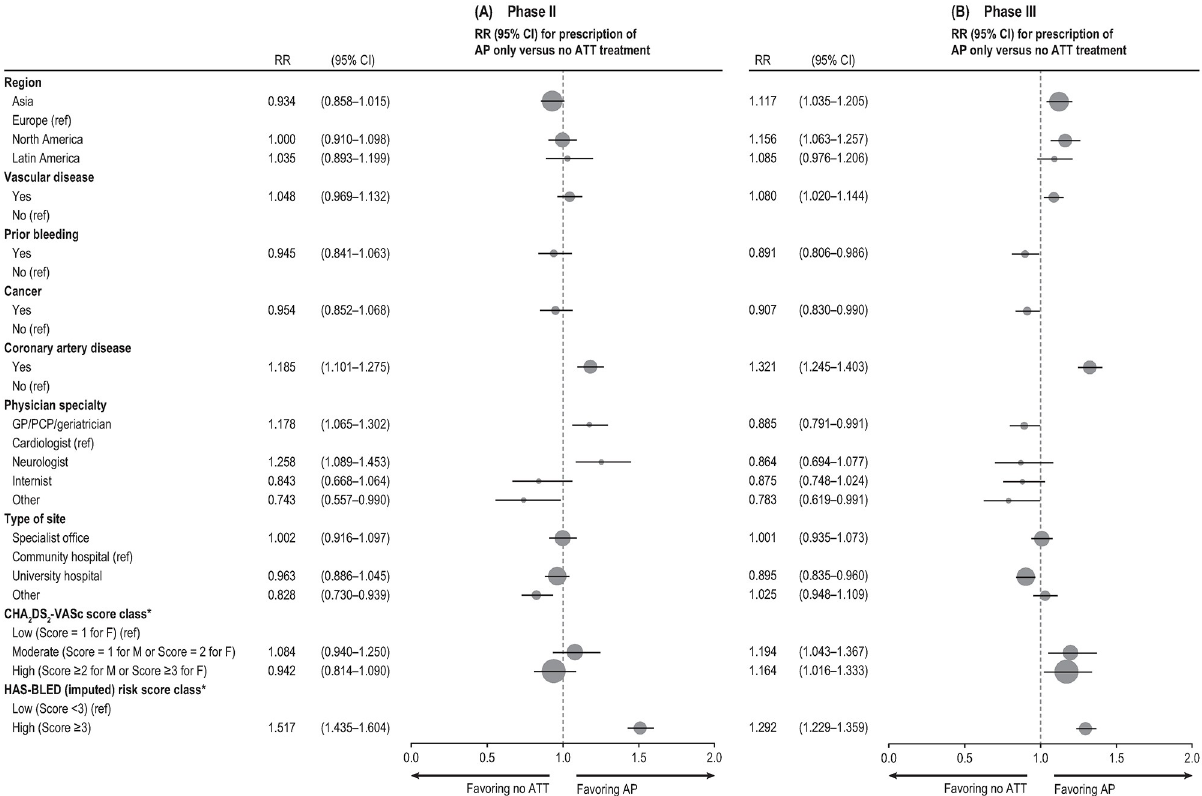
Fig 3. Factors most strongly associated with prescription of AP only versus no ATT in phase II (A) and phase III (B). AP, antiplatelet; ATT, antithrombotic treatment; CHA 2 DS 2 − VASc (congestive heart failure, hypertension, age � 75 years, diabetes, stroke/transient ischemic attack/systemic embolism, vascular disease, age from 65–74 years, sex category [female]); CI, confidence interval; F, female; GP, general practitioner; HAS-BLED (hypertension, abnormal renal/liver function, stroke, bleeding history or predisposition, labile international normalized ratio, elderly [ > 65 years], drugs or alcohol concomitantly); M, male; PCP, primary care physician; ref, reference; RR, relative risk. � Effect estimates obtained from the model including all variables of interest and the risk scores, but not the components of the risk